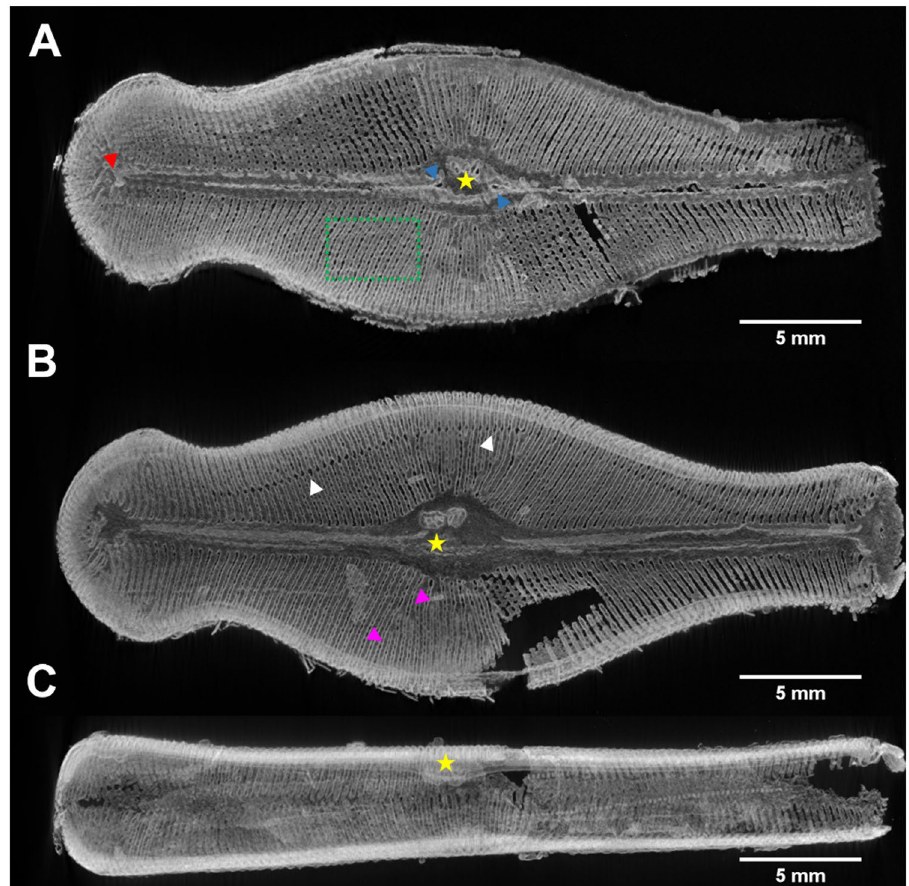
Figure 6. Micro-XCT results of the printed object based on the design of frustule of D. geminata . ( A – C ) Slices extracted from the reconstructed 3D volume in ( A ) valve view – epitheca, ( B ) valve view of the interior – hypotheca, and ( C ) girdle view of the “frustule”. Yellow star: stigmata, red arrowhead: raphe distal end, blue arrowheads: raphe proximal ends, purple arrowheads: ribs, white arrowheads: girdle band, green rectangle: